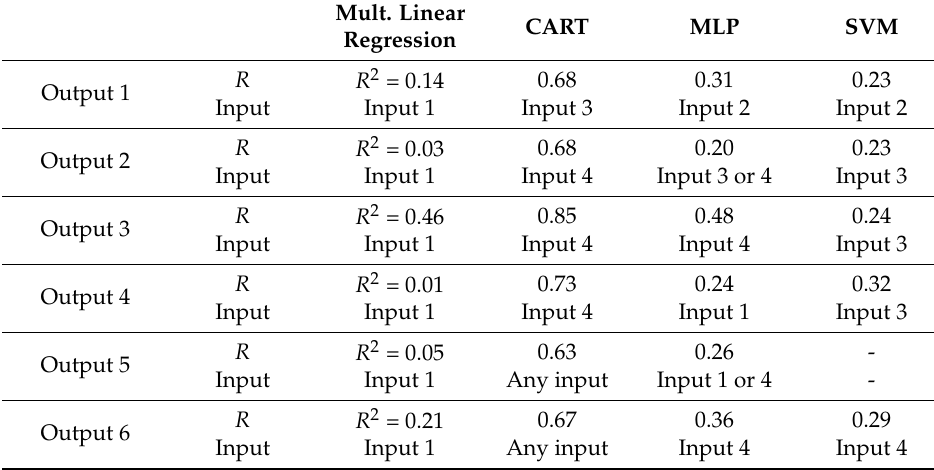
Table 2. Summary of the best results obtained for multiple linear regression, Classification and each